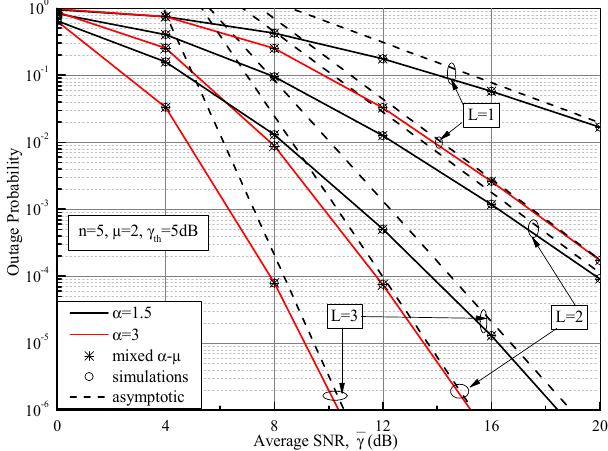
Figure 3. Outage probability of various communication systems as a function of the average SNR over i.i.d. α - µ /IGA fading channels with n = 5, µ = 2, and γ th = 5 dB.